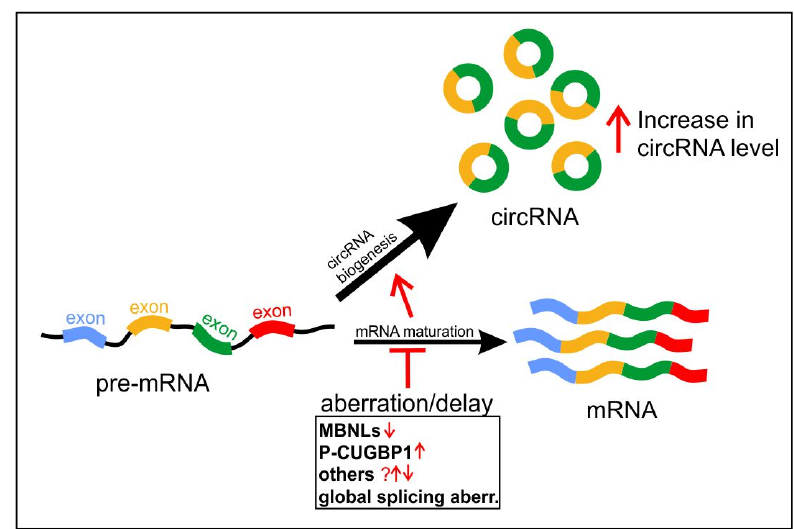
Figure 5. Projected mechanism of circRNAs upregulation in DM1. Global aberrations of alternative splicing are prominent features of DM1 pathogenesis. The functional depletion of MBNL proteins and changes in other proteins including splicing factors (e.g., phosphorylation of CUGBP1, P-CUGBP1) are found in DM1. Altogether, these factors may contribute to circRNAs biogenesis triggering a misbalance in the processing of pre-mRNAs into mRNAs and circRNAs. This misbalance is indicated by the size of black arrows, and by the red arrows indicating the shift toward circRNA biogenesis. The “T” bar indicate aberration/delay in mRNA formation.